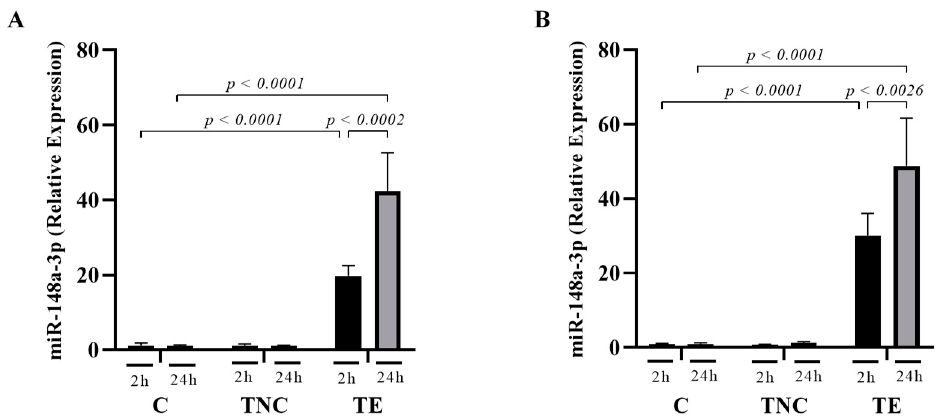
Figure 4. Cellular uptake of mimic hsa-miR-148a-3p. Relative expression of hsa-miR-148a-3p in HepG2 ( A ) and Caco-2 ( B ) cells exposed to either 100 µg protein/mL of exosomes transfected with 100 µM of mimic hsa-miR-148a-3p (TE) or negative 100 µ M of mimic hsa-miR-148a-3p (TE) or negative control miRNA (TNC). Non-treated cells were control miRNA (TNC). Non-treated cells were used as controls (C). Values were standardized with RNU6. Values are used as controls (C). Values were standardized with RNU6. Values are means ± SEMs; n ≥ means ± SEMs; n ≥ 3 independent experiments. p- valu e < 0.05 was considered as statistically significant.